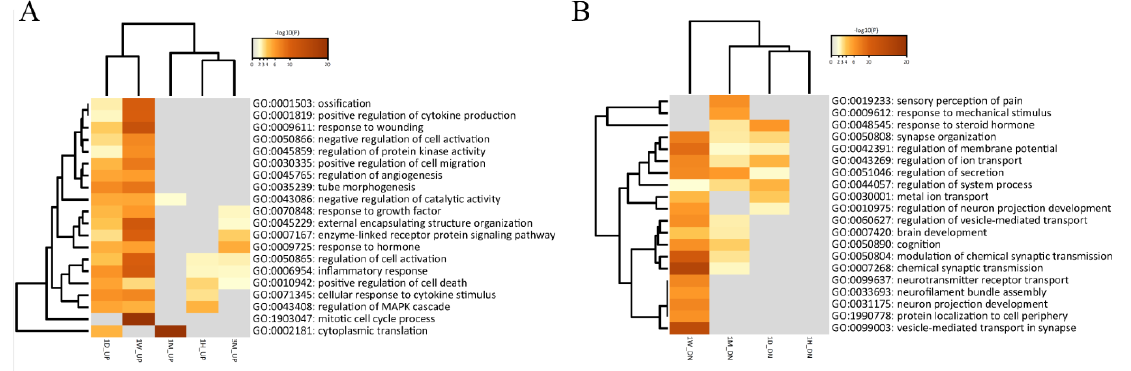
Figure 4. Functional classification of time-series DEG clustering by the DPGP algorithm. The functional classification for up- ( A ) and downregulated ( B ) genes in SCI are screened and visualized. The bar chart of clustered enrichment ontology categories (GO) with a discrete color scale represents statistical significance, and white cells indicate the lack of enrichment for that term in the corresponding gene list.